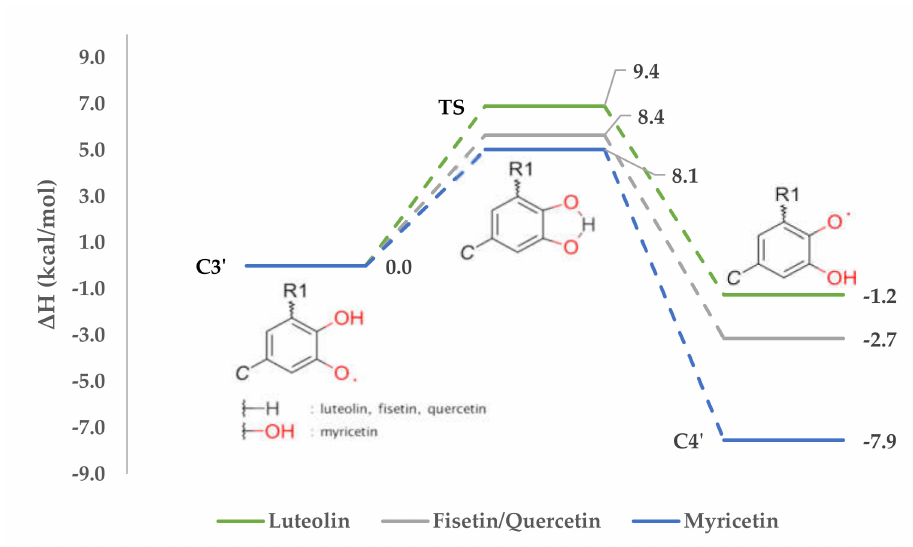
Figure 5. Reactions profile of intramolecular hydrogen swap.